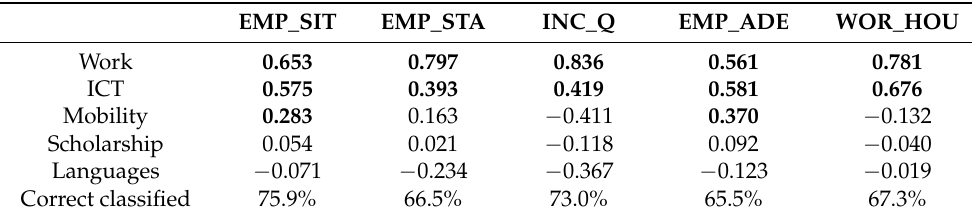
Languages − 0.019 Correct classified